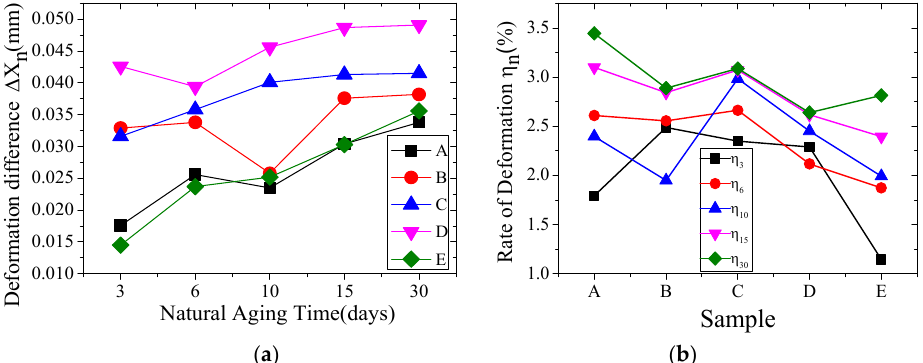
Figure 15. Deformation comparison after natural aging and after machining. ( a ) Deformation difference; ( b ) change in the rate of deformation.